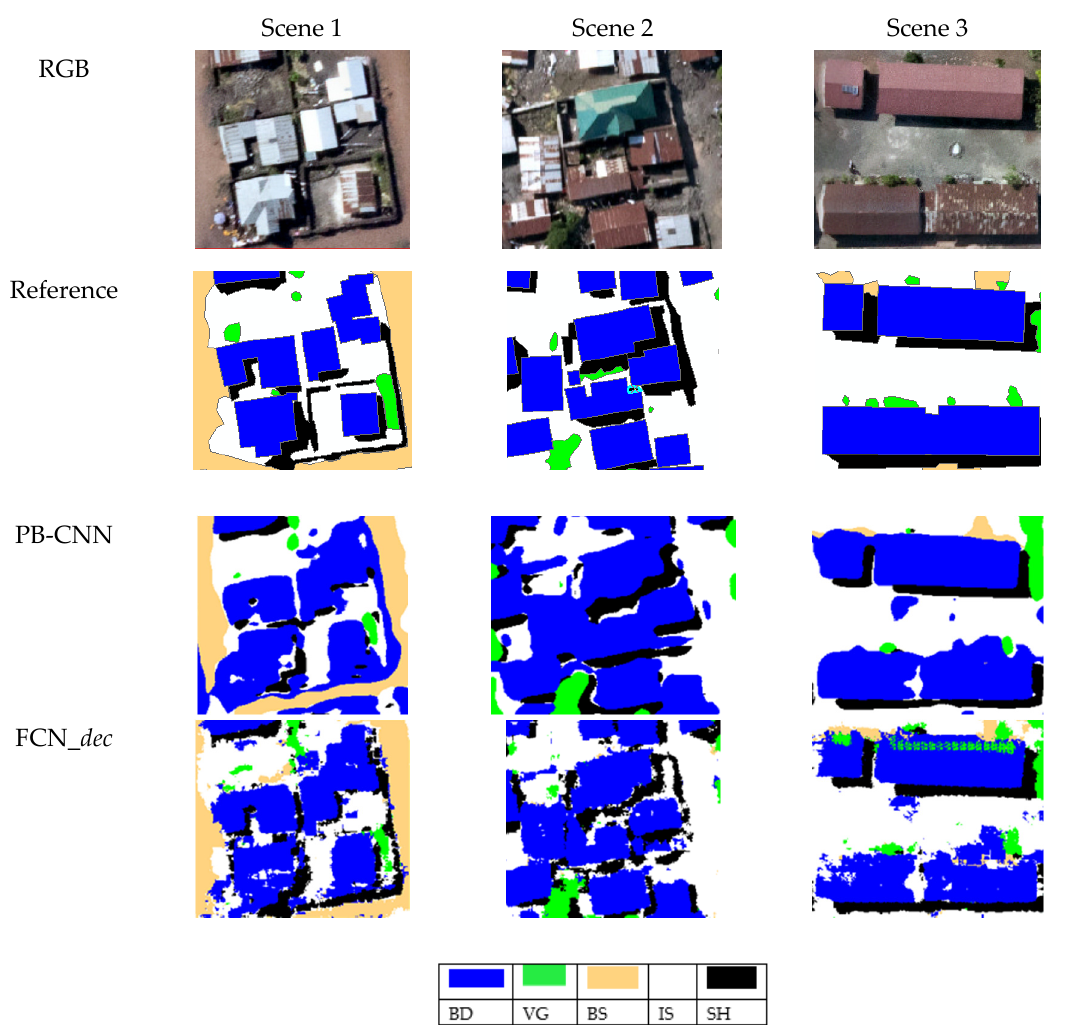
Figure 8. Classification maps of samples scenes for PB-CNN and FCN _dec methods. BD-Building, VG- Vegetation, BS- Bare Soil, IS- Impervious surfaces, SH- Shadows